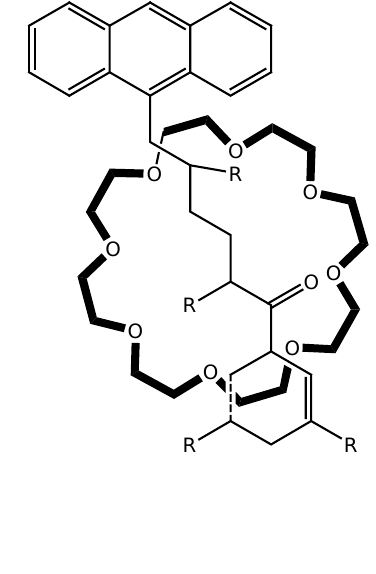
Figure 7. Rotaxane.